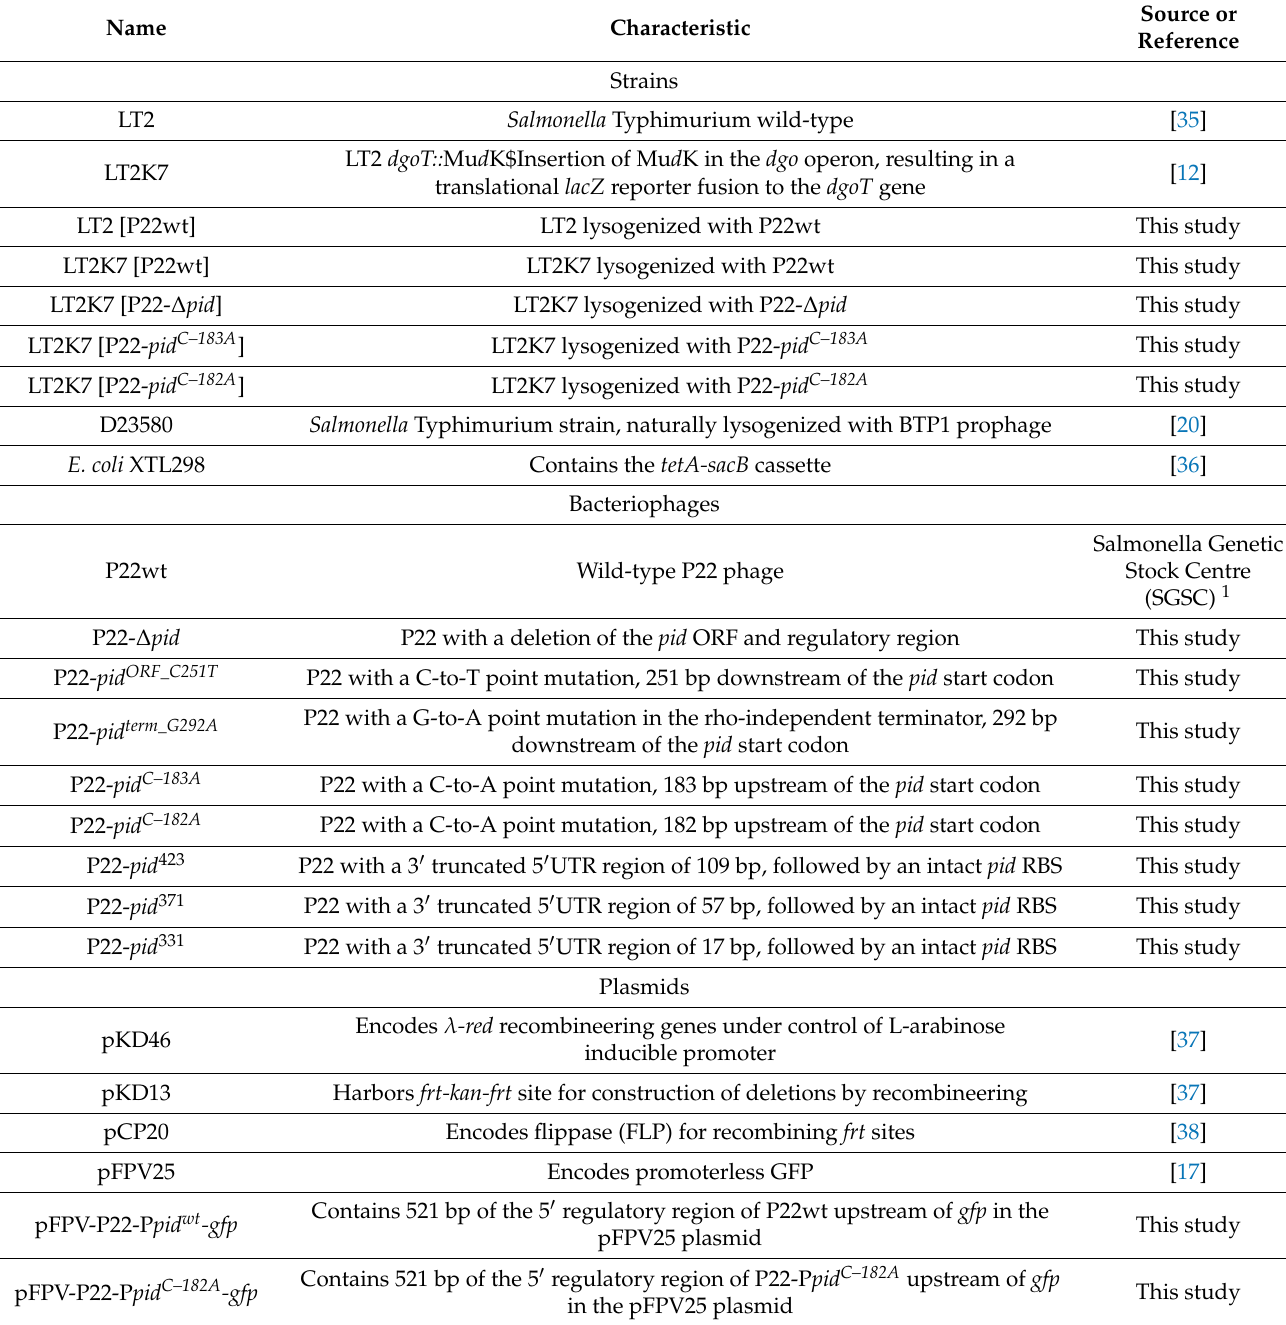
Table 1. Strains, bacteriophages, and plasmids used in this